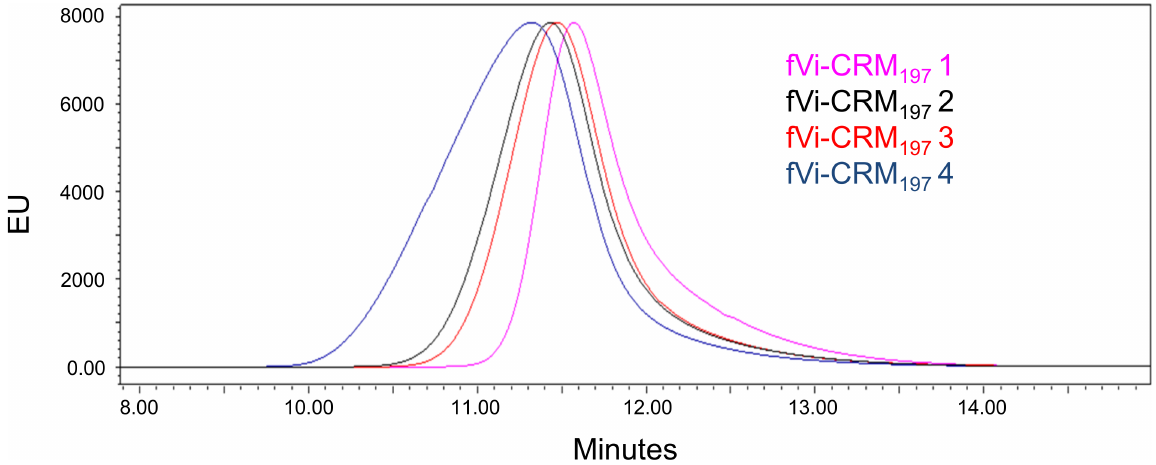
Fig 4. HPLC-SEC profiles (fluorescence emission detection) on TSK gel 3000 PWxl column (NaH 2 PO 4 100 mM, NaCl 100 mM, 5% CH 3 CN pH 7.2; 0.5mL/min) of fVi-CRM 197 conjugates 1 (pink), 2 (black), 3 (red) and 4 (blue) (Table 2).